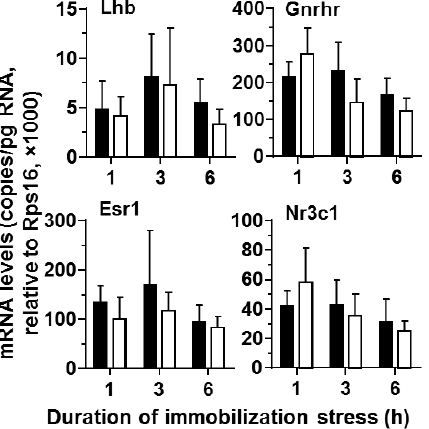
Figure 4. Messenger RNA levels of testes from control and stressed rats during the course of immobilization stress. Control (black bar) and immobilization stress (white bar). Mean ± SEM ( n = 6). Letters a, b, and c indicate significant difference compared to